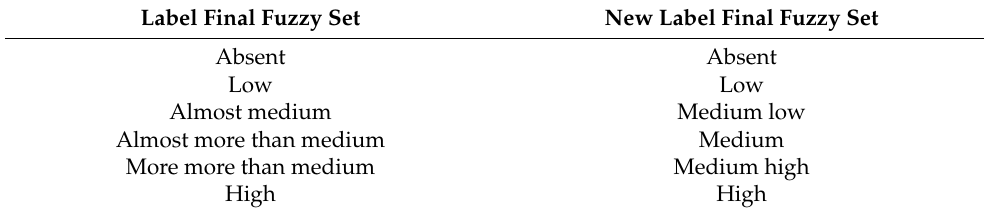
Table 9. New labels assigned by the expert to the final fuzzy sets. Label Final Fuzzy Set